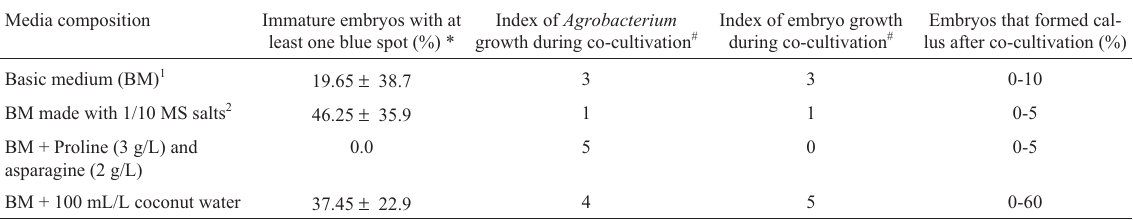
Table5 -Effectofco-cultivationmediaontransientGUSexpressioninimmatureembryos,growthof Agrobacterium ,embryogrowthandthepercentage of embryos that formed callus after co-cultivation. Results based on several experiments with 50 embryos in each treatment. Media composition